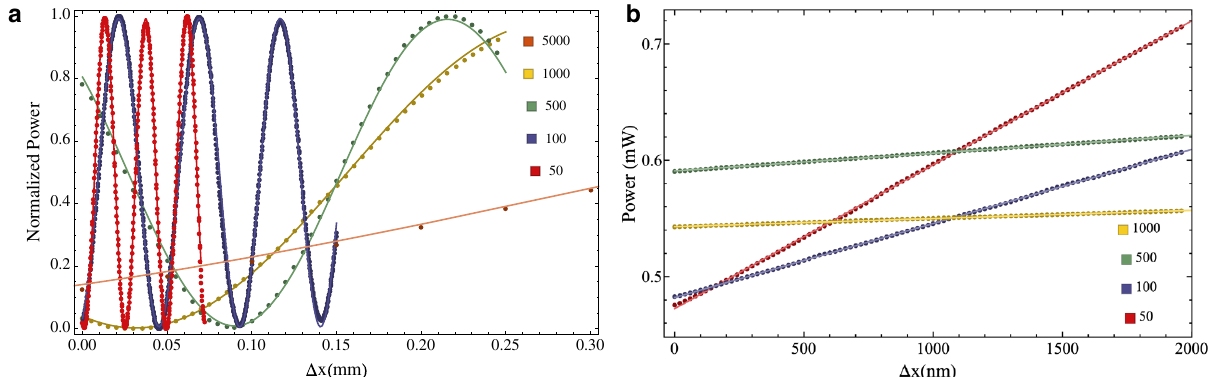
Fig. 2 Experimental results. a For each value of Λ , we reported the normalized measured power of the horizontal polarization component, as a function of the displacement between the two g -plates. The zero displacement point for each curve has been set to allow easy visual comparison between different gears. b The same measurement is repeated in the linear part of the calibration curves, with a displacement step of 20 nm. For each con fi guration, the input optical power was set to a reference value P 0 = 1 mW. In both panels, points represent experimental data, solid lines are best- fi t curves according to equations in the main text, experimental points correspond to the average power over 20 independent measurements (error bars, corresponding to standard deviations, are smaller than the data point size). Speci fi c colors label datasets that are associated with different spatial periods Λ (expressed in μ m in the comparison between the slopes of the curves clearly shows the Fig. 2a, together with the best- fi t curves according to Eq. (5). advantage in terms of sensitivity that is obtained by decreasing Λ . Obtained data nicely reproduce the expected oscillatory behavior. This can be readily quanti fi ed by performing a linear fi t for each curve. The best sensitivity S = 124.0 ± 0.1 nW/nm was obtained, as expected, for g -plates with Λ = 50 μ m. We, therefore, evaluated the actual resolution of our detection system for this con fi gura- tion. To this end, we repeatedly measured the optical power for a time interval of 1 s (250 points), before and after a controlled step of the translation stage. We report these results in Fig. 3, where the red dots represent experimental data, while black dashed lines